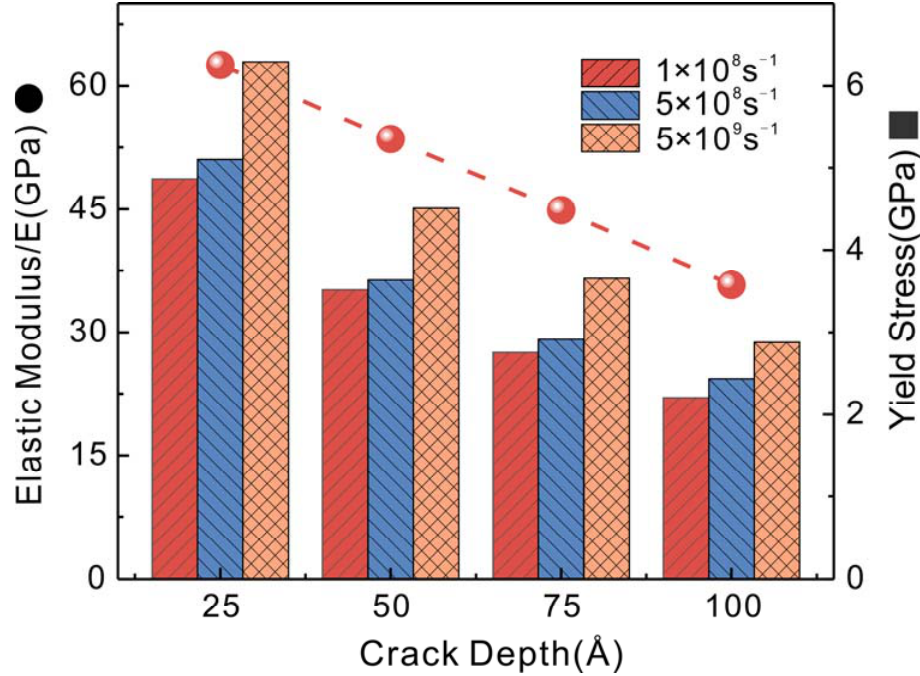
Figure 2. Variation of elastic modulus and yield stress with crack depth at di ff erent strain rates.